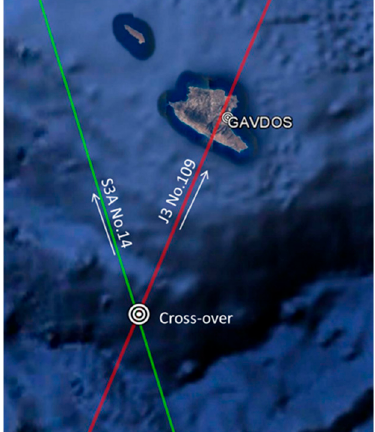
Figure 13. The cross-over location of Sentinel-3A Pass No.14 and Jason-3 Pass No.109 south of Gavdos Cal/Val site.